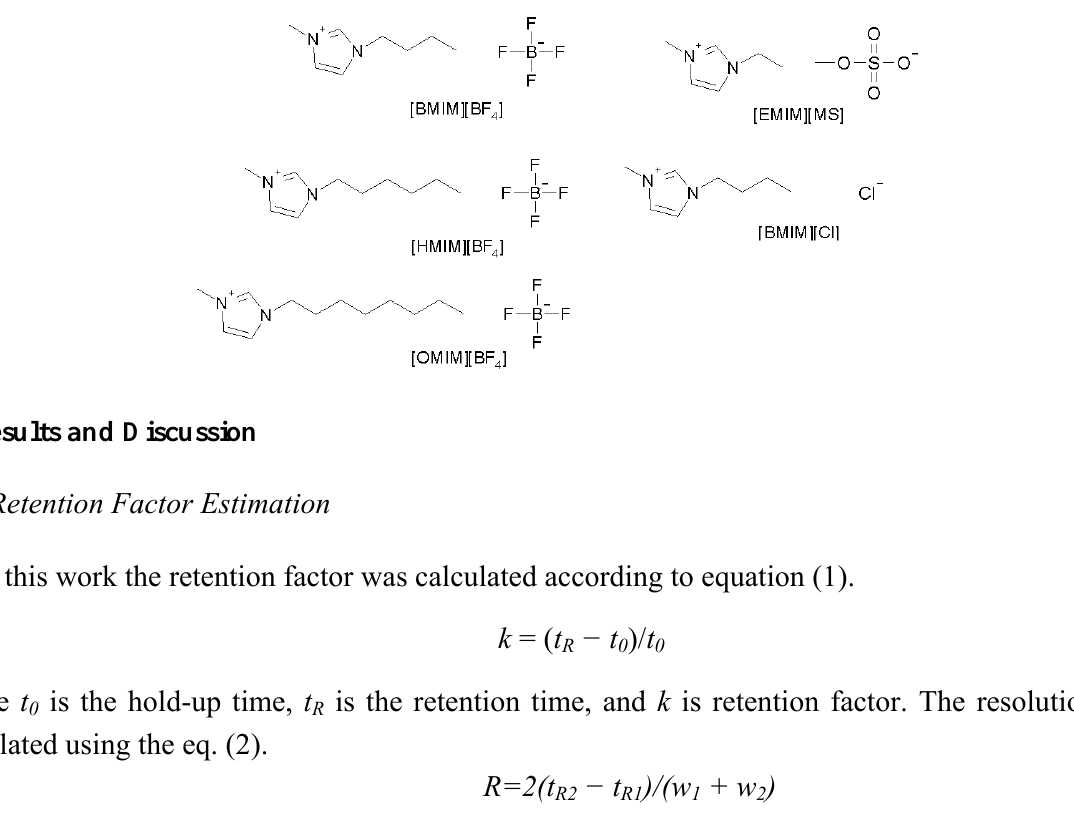
Figure 2. The chemical structures of the ionic liquids used as mobile phase